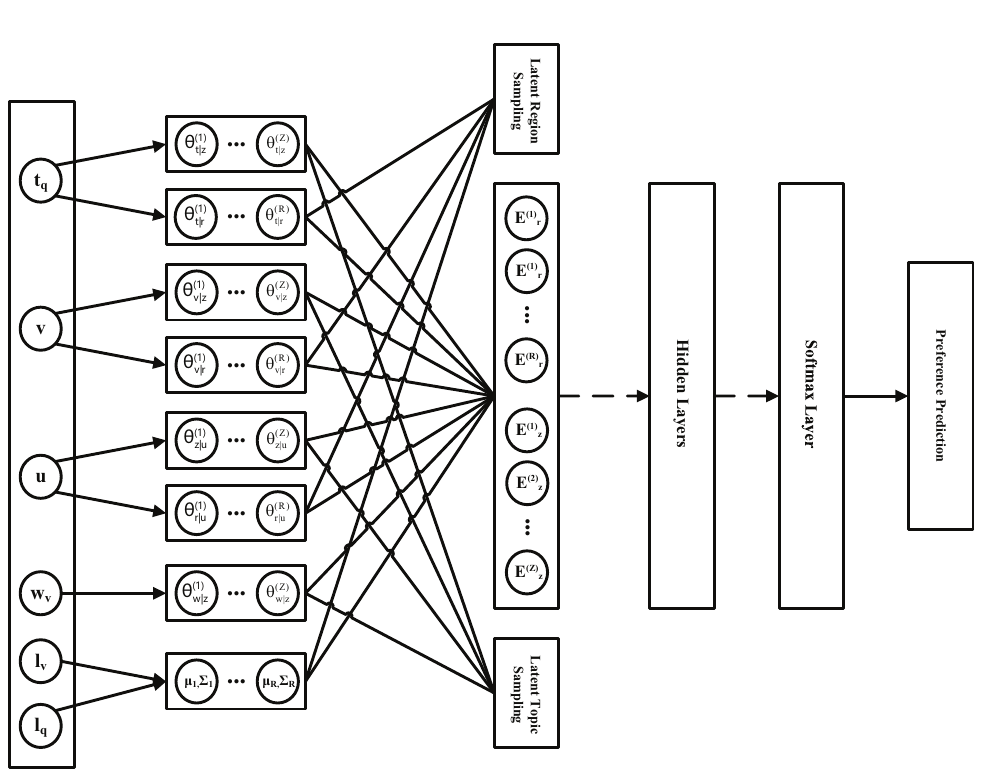
Figure 2. The Graphical Representation of